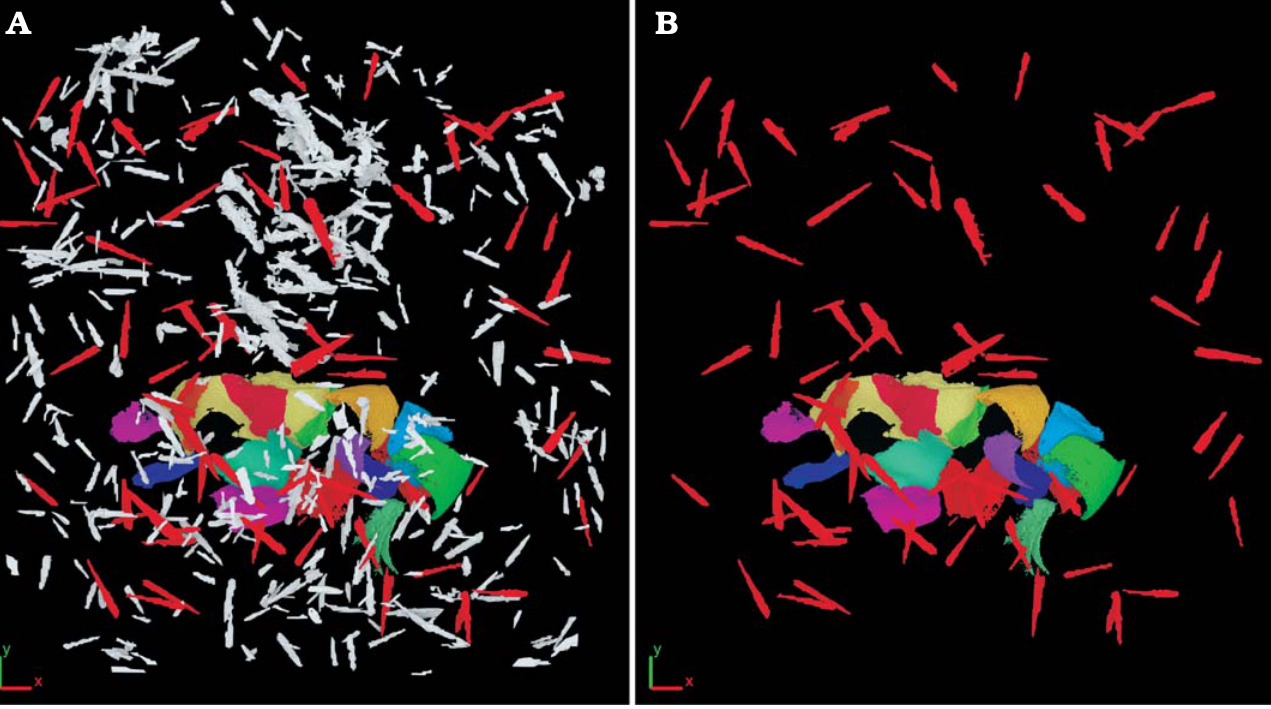
Fig. 7. Overview of objects interpreted as dacryoconarids surrounding the machaeridian sclerites. A . All objects including the ones discarded for further analysis (light grey). B . Dacryoconarids selected for measurements